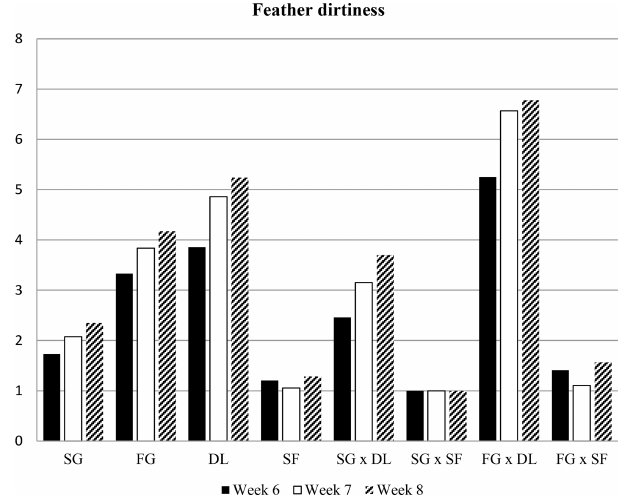
Figure 3. Mean values of feather dirtiness scores of all groups. SG: slow growing, FG: fast growing, DL: deep litter, SF: slatted floor.